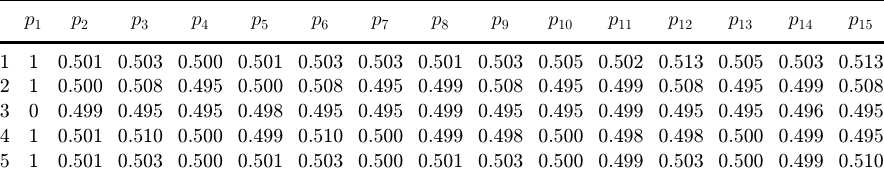
Table 4. First ¯ve out of the 64 sample